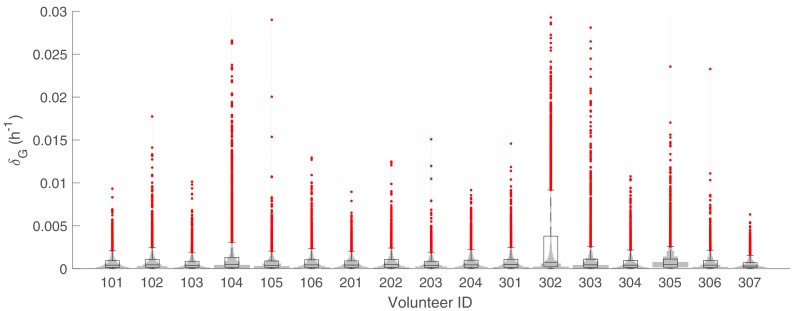
The marginal posterior distributions of the individual parameter of δG (death rate of sequestered gametocytes) for all 17 volunteers.The violin plots (gray area) show the distributions of 5000 posterior samples. Box plots show the 25%, 50% (median) and 75% quantiles with outliers indicated by red dots. Relevant details of the individual parameter are provided in the Materials and methods in the main text.